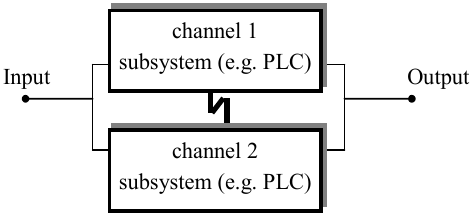
Figure 13. Programmable electronic system with two channels.